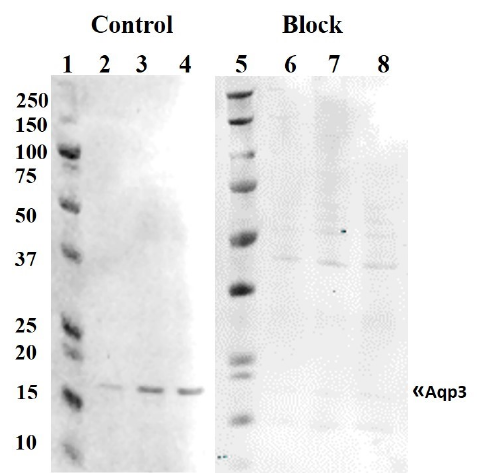
Figure 3. Western blot of FW medaka gill protein probed with an antibody against medaka AQP3. Lanes 2–4 were probed with the AQP3 antibody; lanes 5–8 were probed with the antibody after neutralization with 400x molar excess of the antigenic peptide. Lanes 1 and 5 contained a molecular mass marker (Protein Plus, BIO-RAD, Hercules, CA); lanes 2–4 and 6–8 contained 5, 10, and 15 µ g of total loaded protein, respectively. A single immunoreactive band at ~18 kDa was detected, which was not present after antibody neutralization.